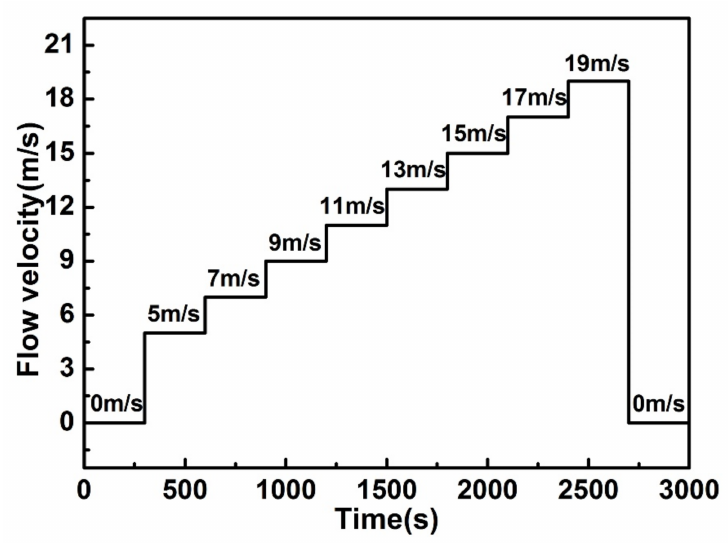
Figure 4. Variation of flow velocity versus impingement